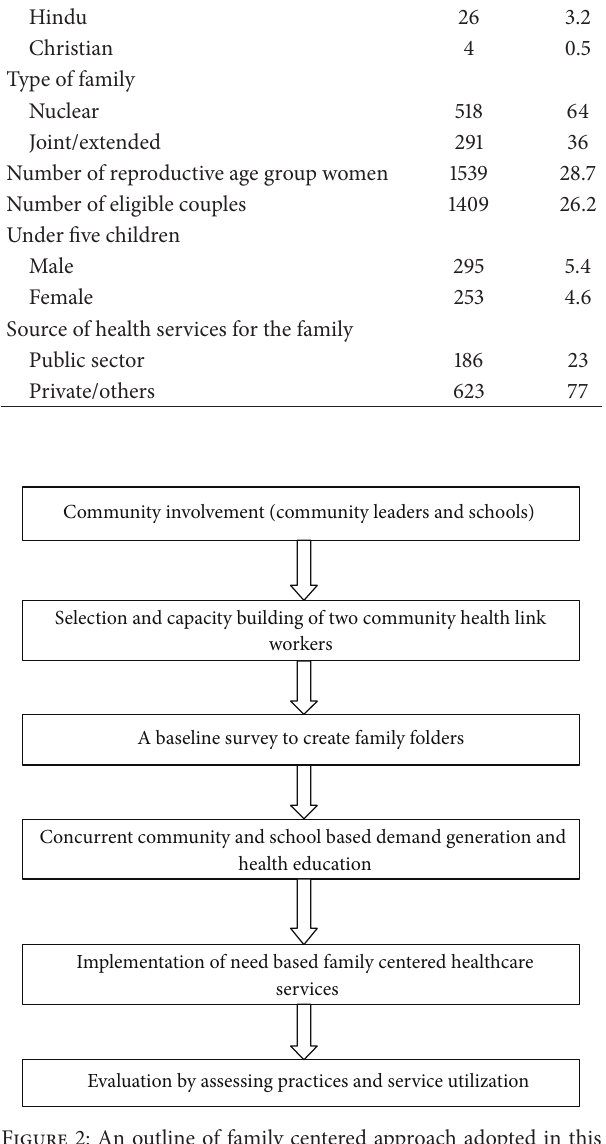
Figure 2: An outline of family centered approach adopted in this study.